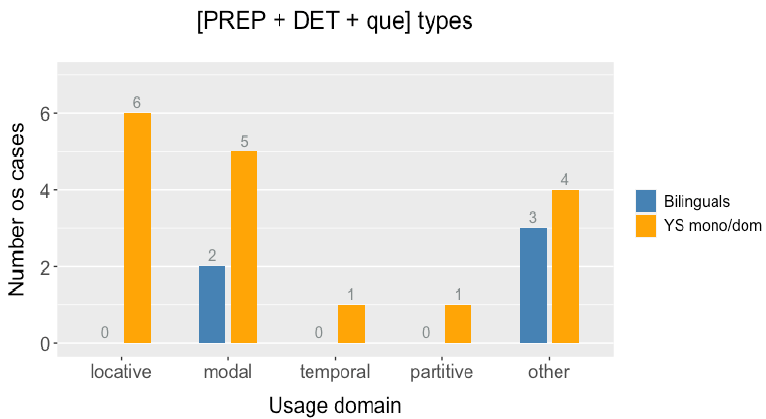
Figure 5. Results for complex complementizers in the relative clause data, according to the usage domains.